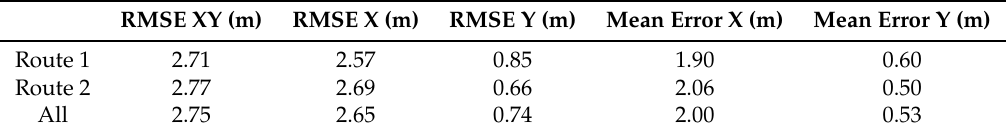
Figure 10. The BLE-derived locations. The black lines indicate the ground truth: ( a ) Route 1; and ( b ) Route 2. Table 1. Accuracy of the positioning method fusing trilateration and fingerprinting of iBeacon.